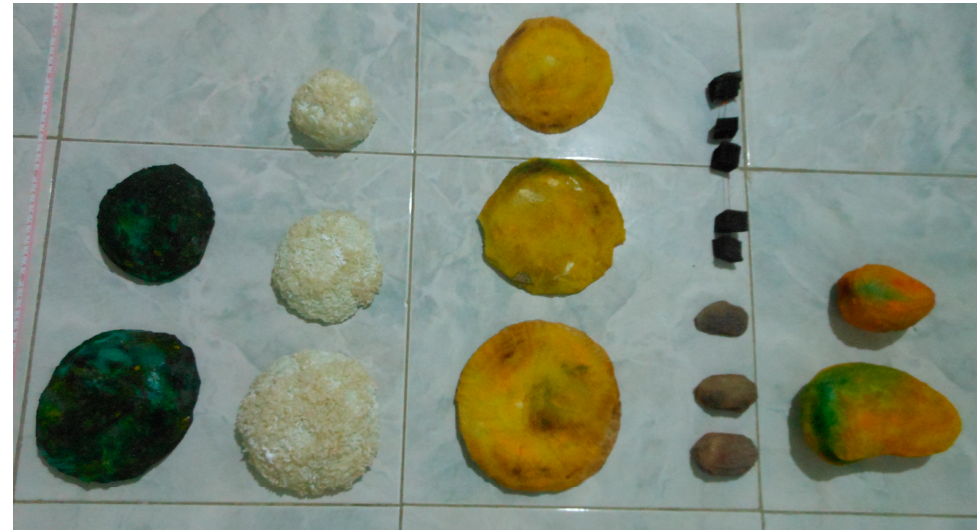
Figure A4. Picture of foam models used to assess portion size, they mimic most common food choices for children in different servings. Models were code labeled.